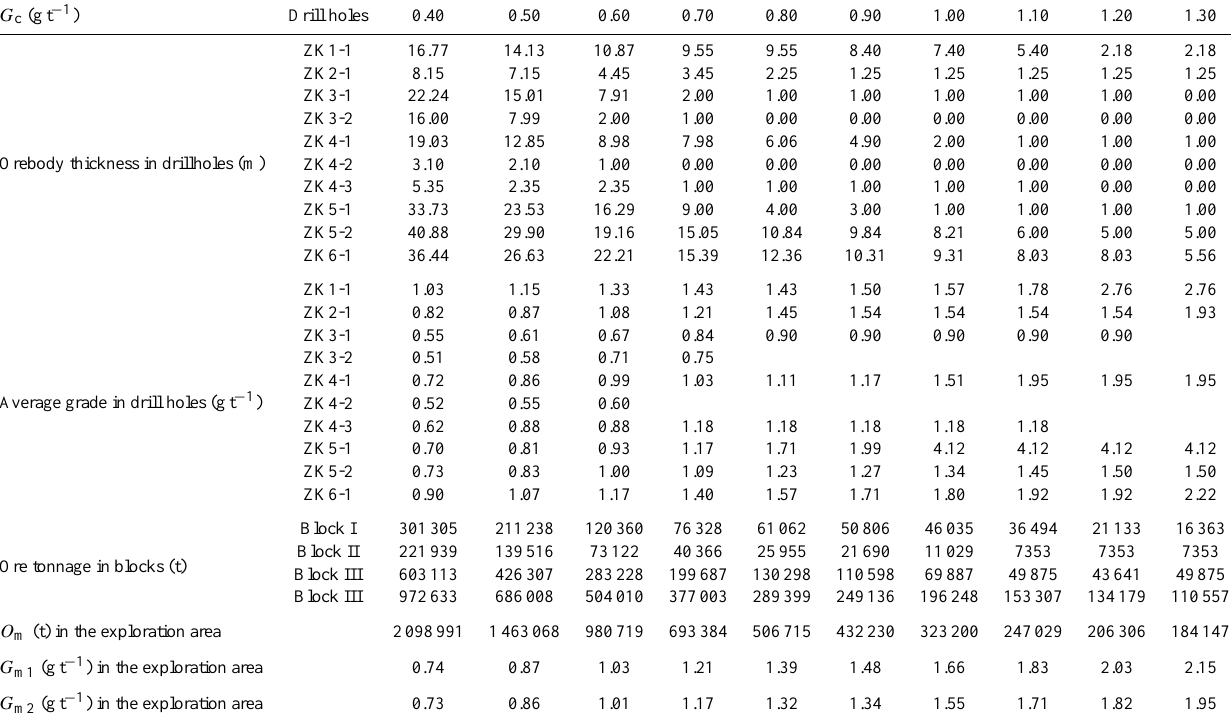
Fig. 6. Vertical cross-section of the exploration line 2, showing the vertical gold concentration curves along the drill holes, in the Reshuitang gold deposit, China. (The map is based on the exploration material provided by the Yunnan Mineral Resources Limited Liability Company). Table 1. The orebody thickness, ore tonnage and average grade as the cutoff increases in an exploration area in the Reshuitang gold deposit,